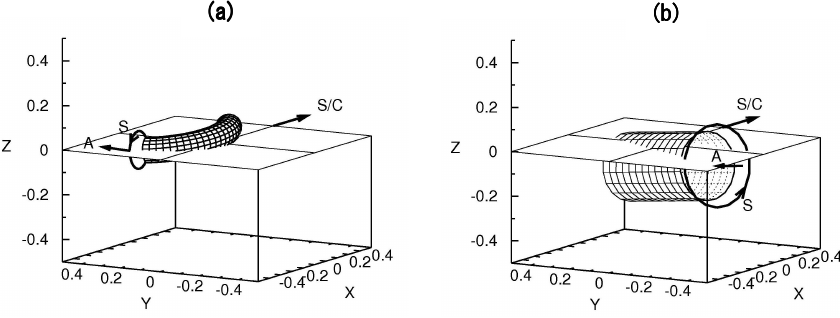
Fig. 11. Two geometries obtained for the magnetic cloud of 27 May 1996 (Event No. 2), from the fittings to the torus model (a) and to the cylinder model (b)